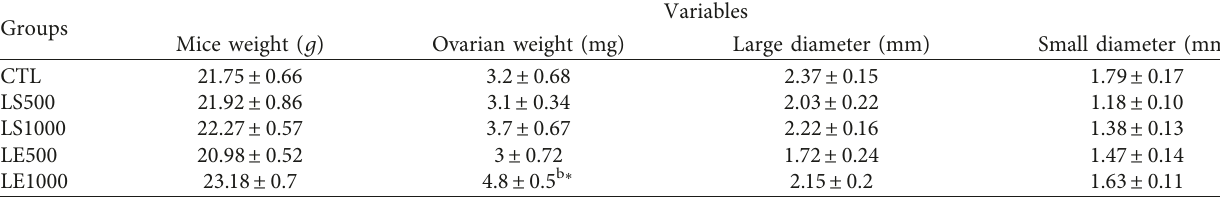
The values are expressed as mean ± SEM. The values are comparable in the same column, b Significant difference versus LS500 group; ∗ p < 0 .